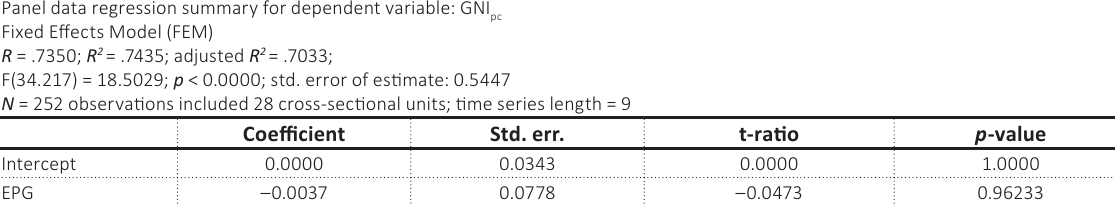
Table 5. Panel data regression analysis between GNI Panel data regression summary for dependent variable: GNI Fixed Effects Model